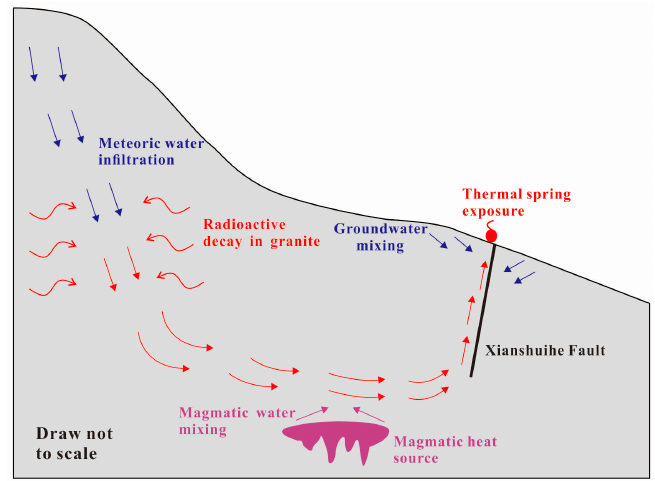
Figure 13. Conceptual model of thermal spring in Kangding County.